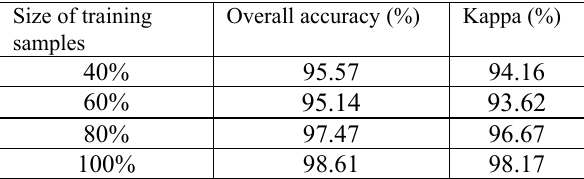
Table 5. Selection of optimum size of training samples